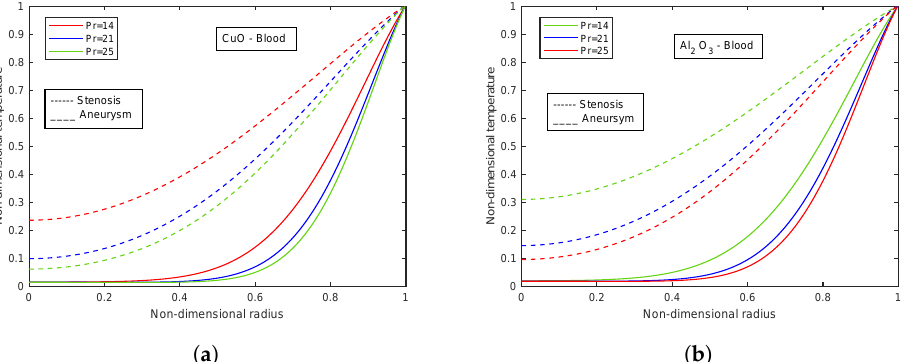
Figure 31. Impact of Prandtl number Pr on temperature profiles for ( a ) CuO-nanoparticles, ( b ) Al 2 O 3